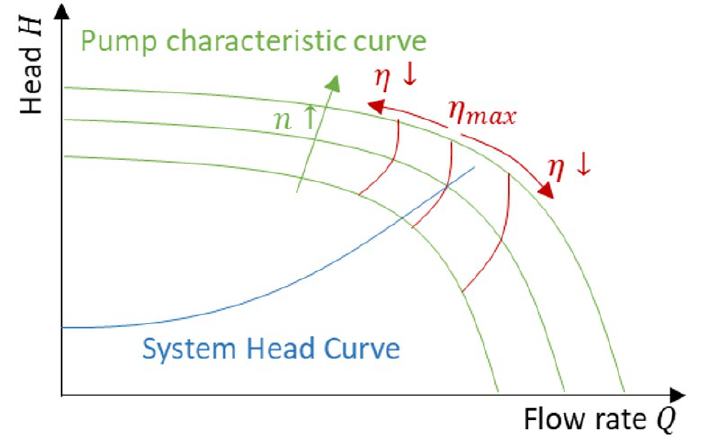
Figure 16. Pump characteristic and system head curves as well as pump efficiency curves.